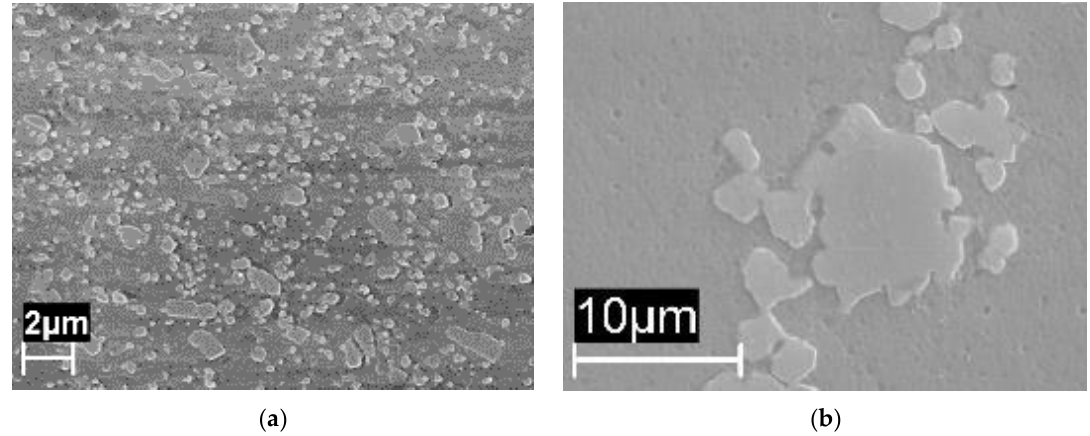
Figure 10. Microstructure of the XZ (T platform 35 °C) specimens heat treated at ( a ) 400 °C and ( b ) 550 °C [38].